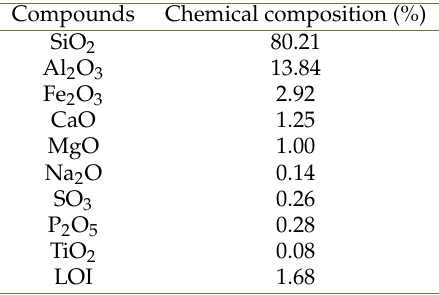
Table 3. Chemical composition of bottom ash.